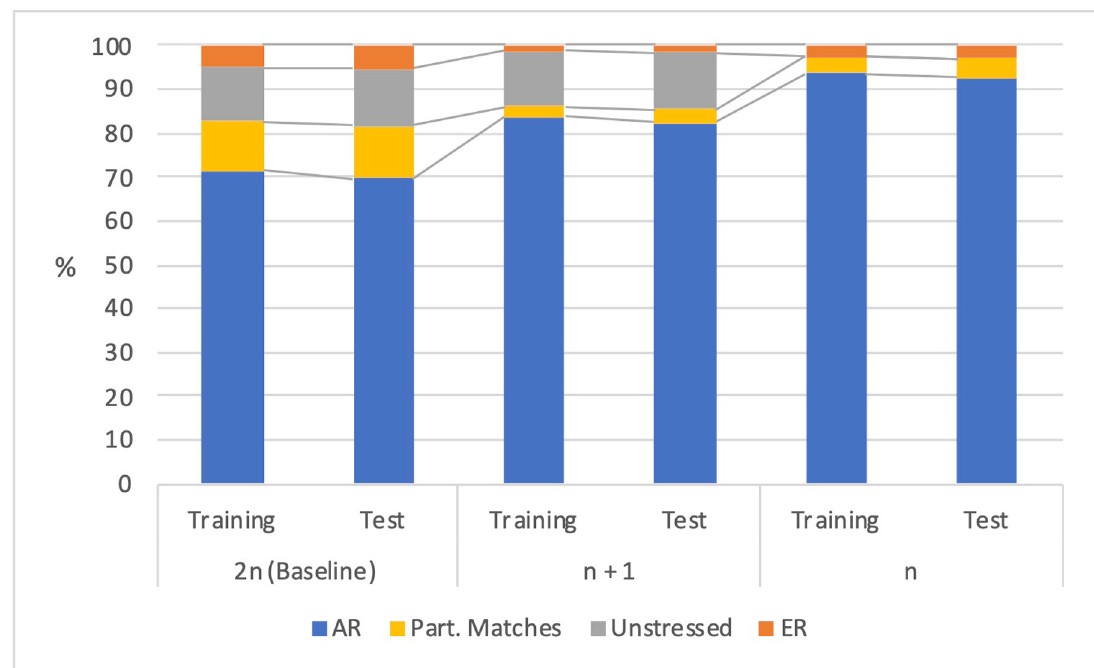
Figure 6: Overall Accuracy, Error, Partial Matches and Unstressed rates (summarized in Table 7).